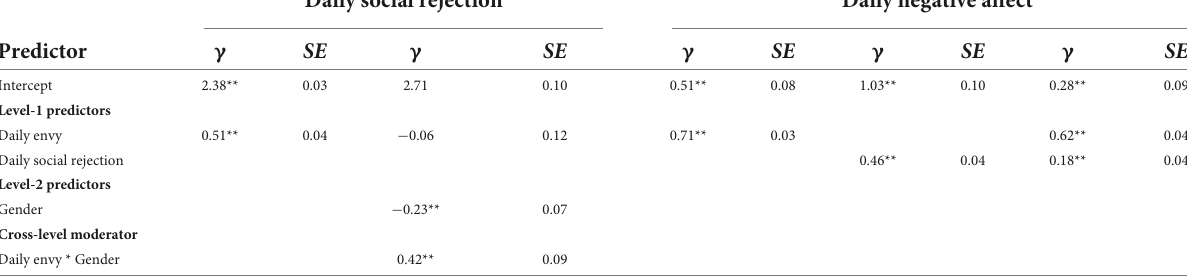
TABLE 2 Multilevel path analysis results for the hypothesized model. Daily social rejection Daily negative affect Predictor